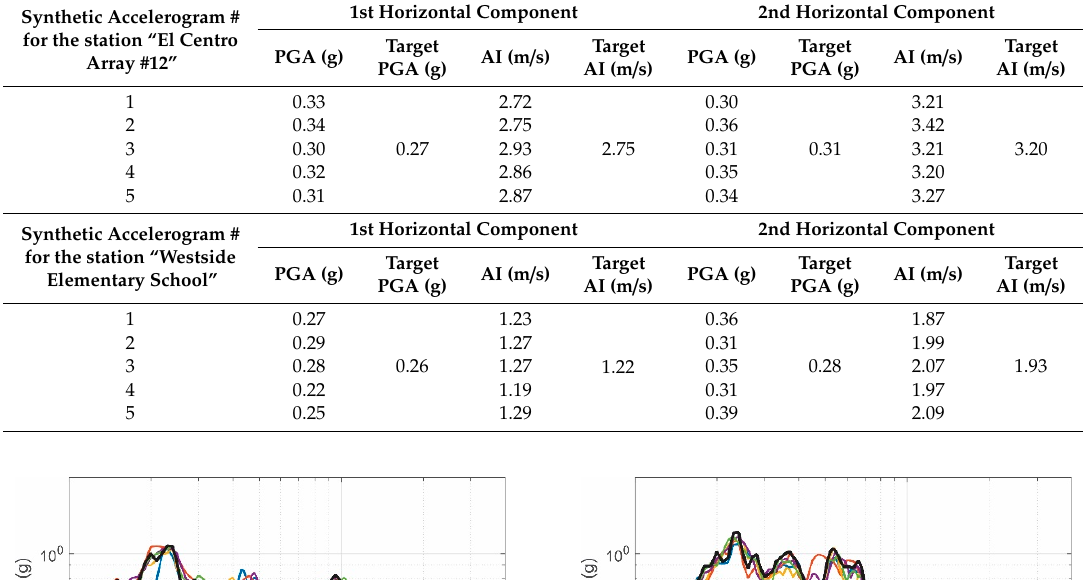
Table 2. Peak ground acceleration (PGA) and Arias Intensity (AI) values for the five synthetic accelerograms that are spectrum-compatible and energy-compatible with the real records from Table 1 for the stations “El Centro Array #12” and “Westside Elementary School”.